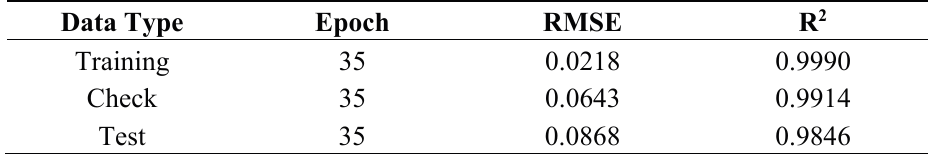
Table 6. The summary of the statistical criteria of RMSE and R 2 of the ANFIS